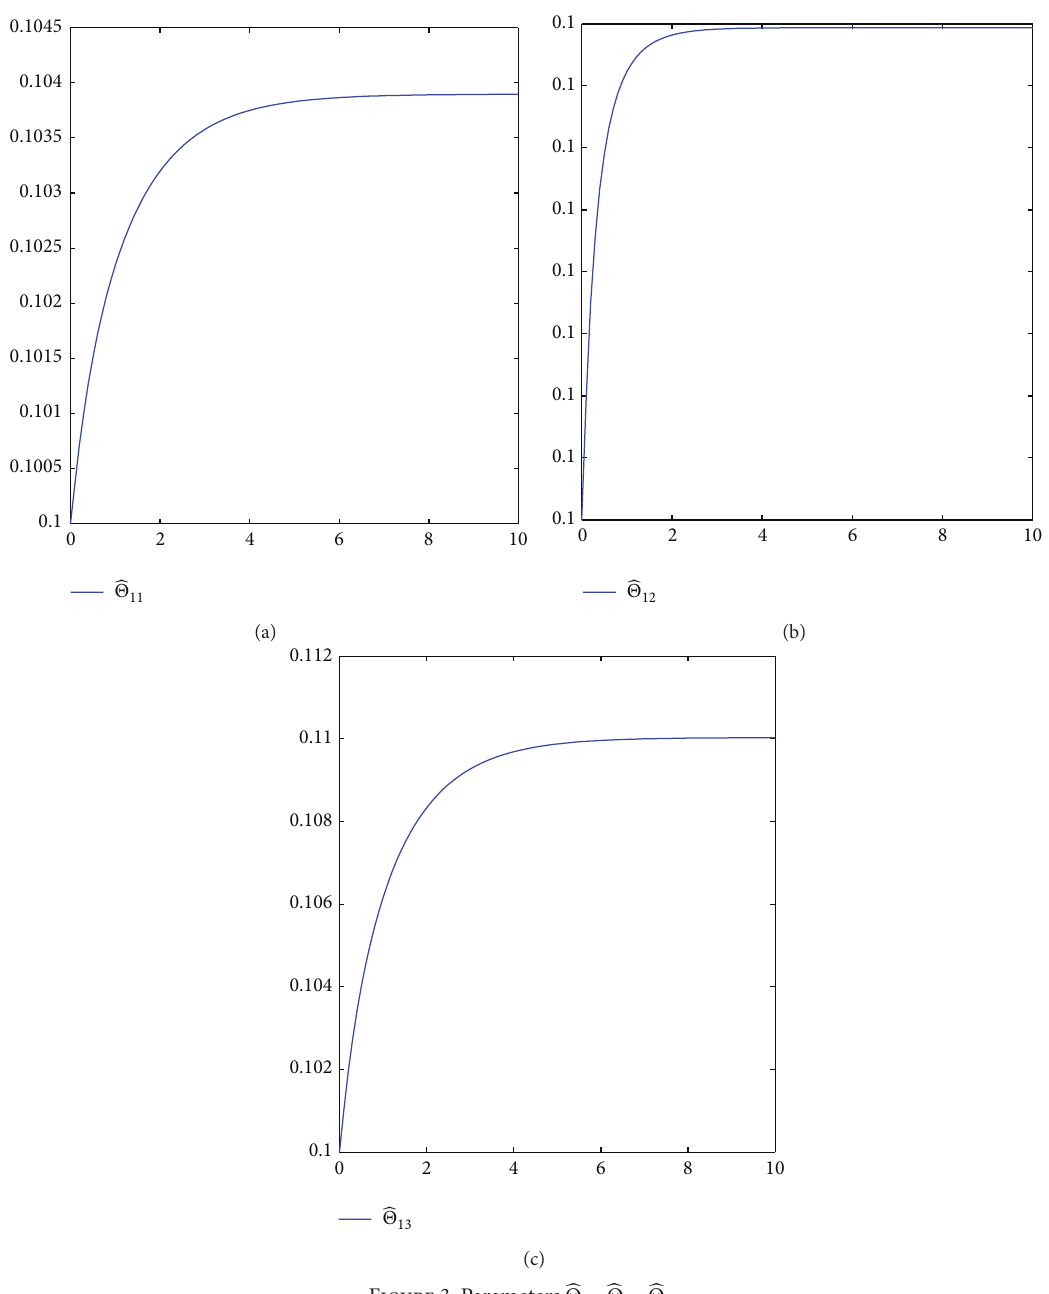
Figure 3: Parameters